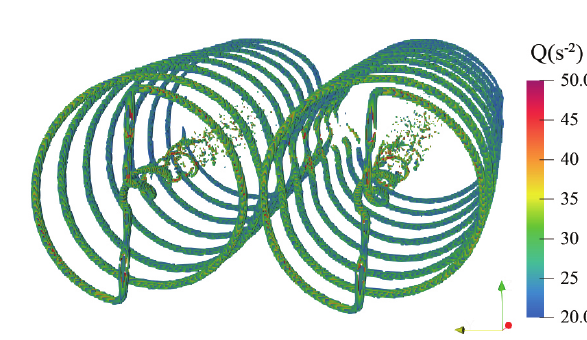
Figure 10. Near-wake with rotor spacing of 0.2 R.